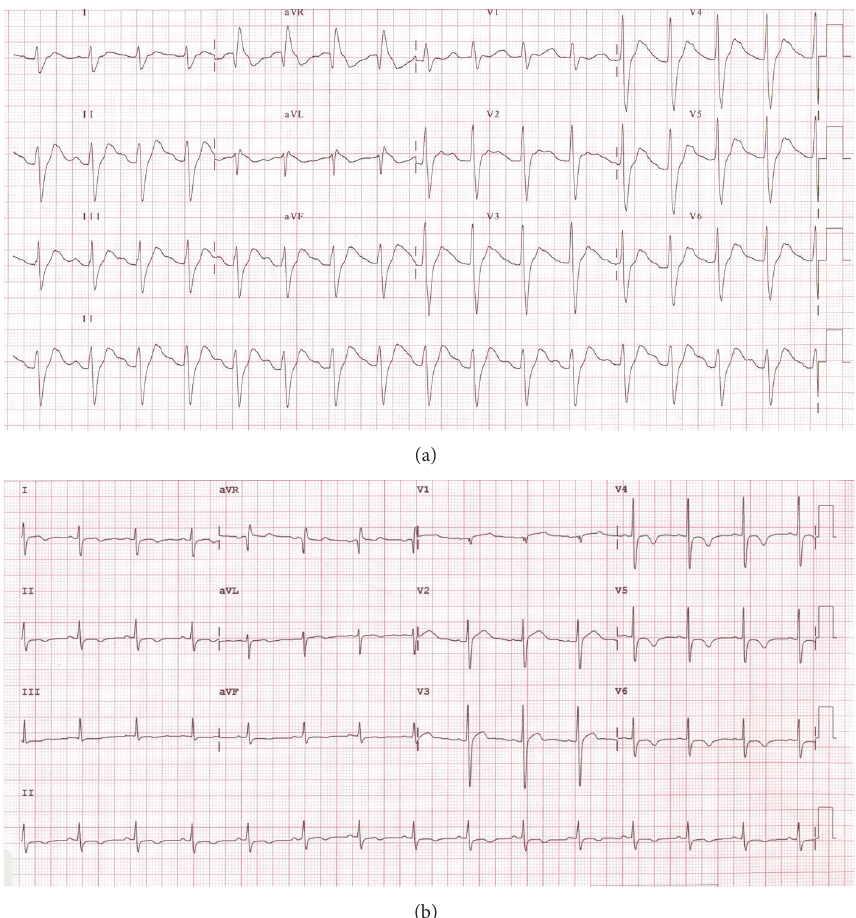
Figure 1: The electrocardiogram (ECG) observed in a 19-year-old man that ingested large amount of crack cocaine ( ± 40grams) in a suicide attempt. The ECG showed sinus tachycardia with significant widening of QRS (200 ms), significant increase in R wave amplitude in aVR (8.0mV), QTc interval prolongation (510ms), and right-axis deviation of the terminal 40ms vector of the QRS complex in the frontal plane (210 ∘ ) during the initial evaluation (a), and gradual decrease in QRS duration (100ms), in R wave amplitude in aVR (4.0mV), in the QTc interval (428 ms), and in right-axis deviation of the terminal 40ms vector of the QRS complex in the frontal plane (150 ∘ ) after intravenous sodium bicarbonate infusion